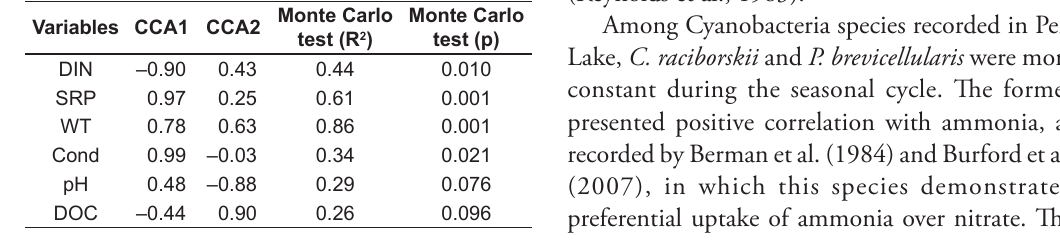
Table 3. Values of the environmental variables with the axes 1 and 2 of CCA and Monte Carlo test.